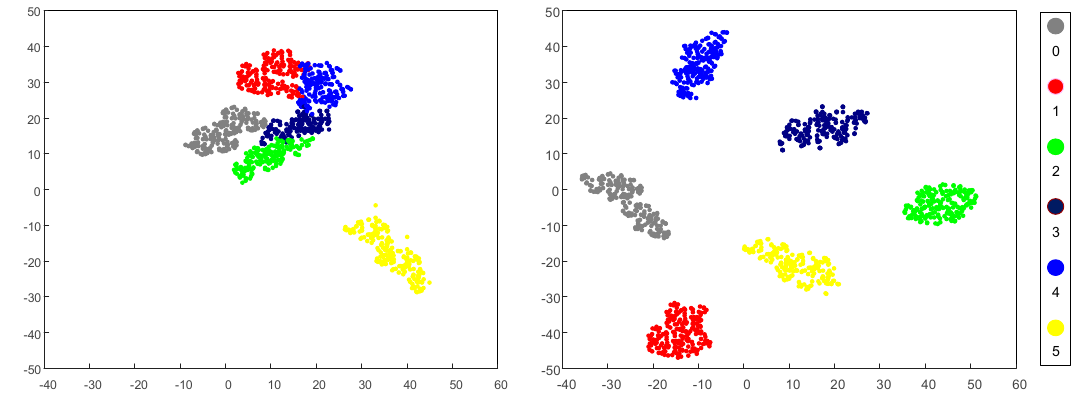
Figure 14. Feature clustering effect diagram: ( a ) raw data and ( b ) SSIF-CNN.